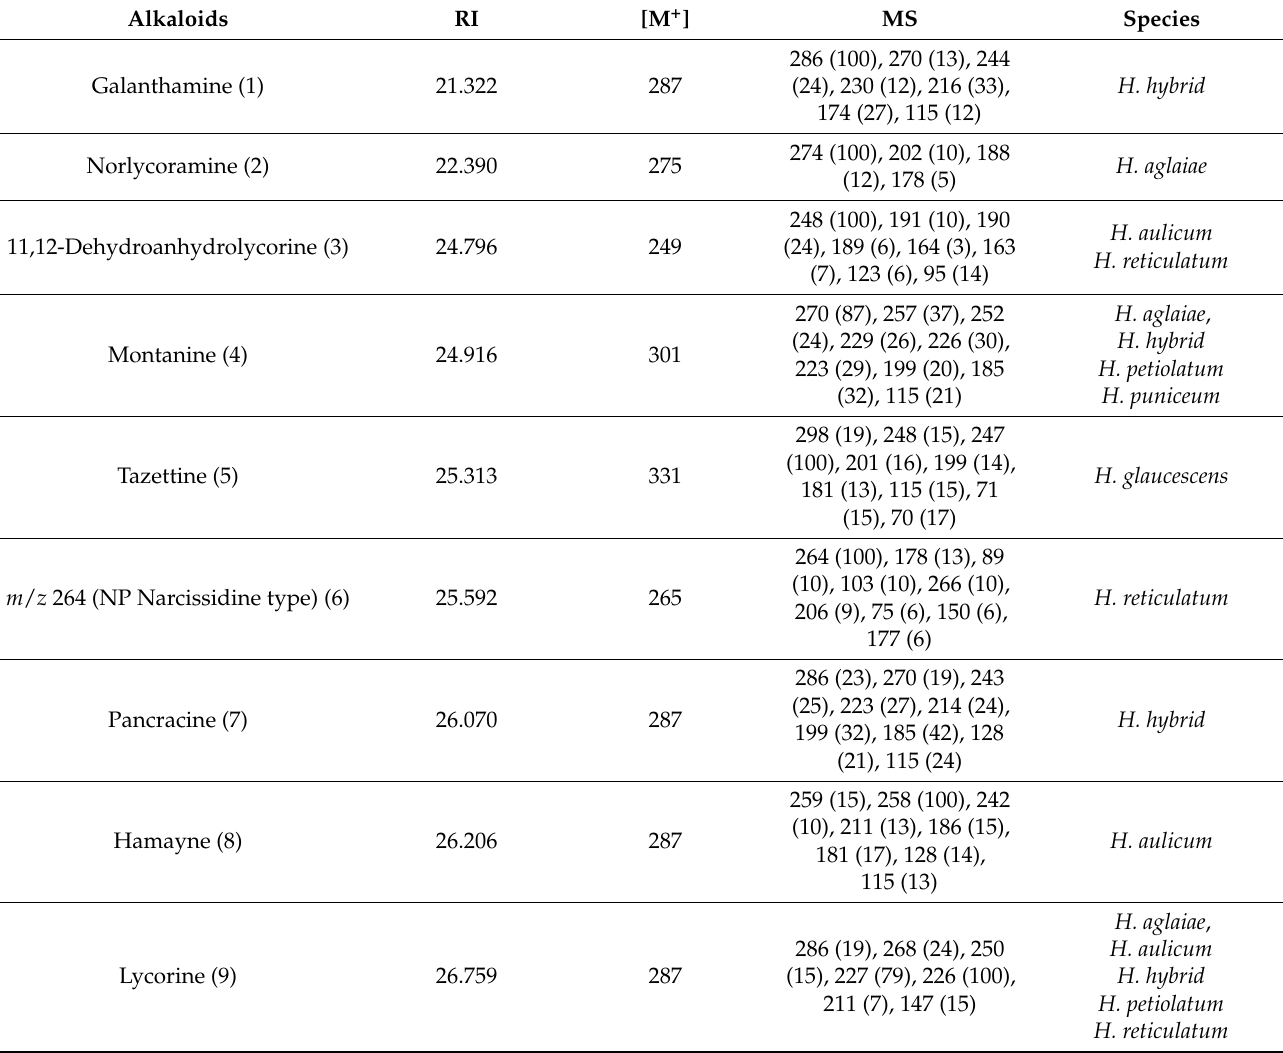
Table 1. Main alkaloids identified in Argentinean Hippeastrum spp. samples by GC-MS